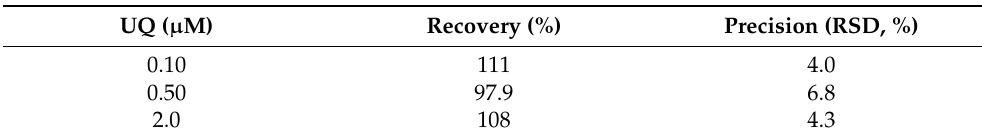
Table 5. The comparison of the sensitivity of the proposed methods with the previously reported methods in the literature.